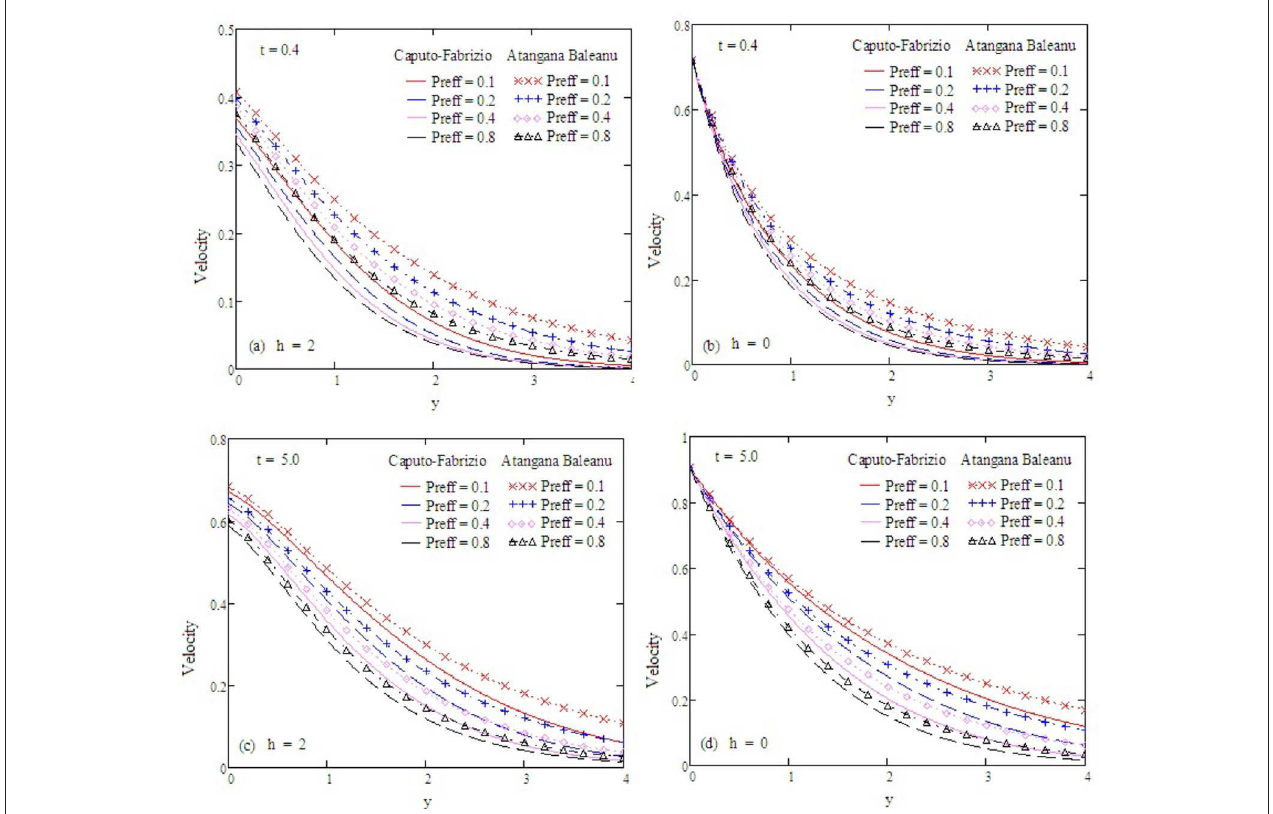
FIGURE 13 | Velocity profiles with altered values of P reff and other parameters are ω